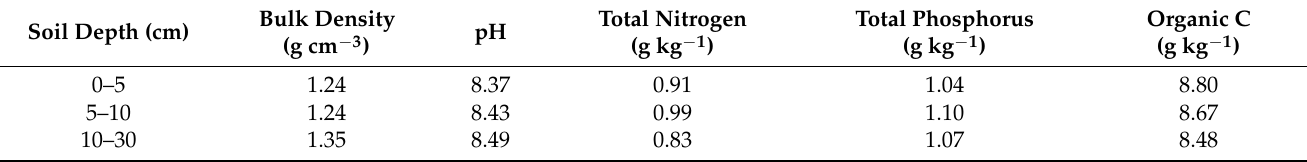
Table 1. Initial physiochemical properties in the soil before the experimental